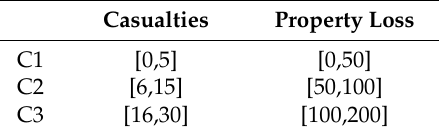
Table 2. Criteria of emergency loss levels.